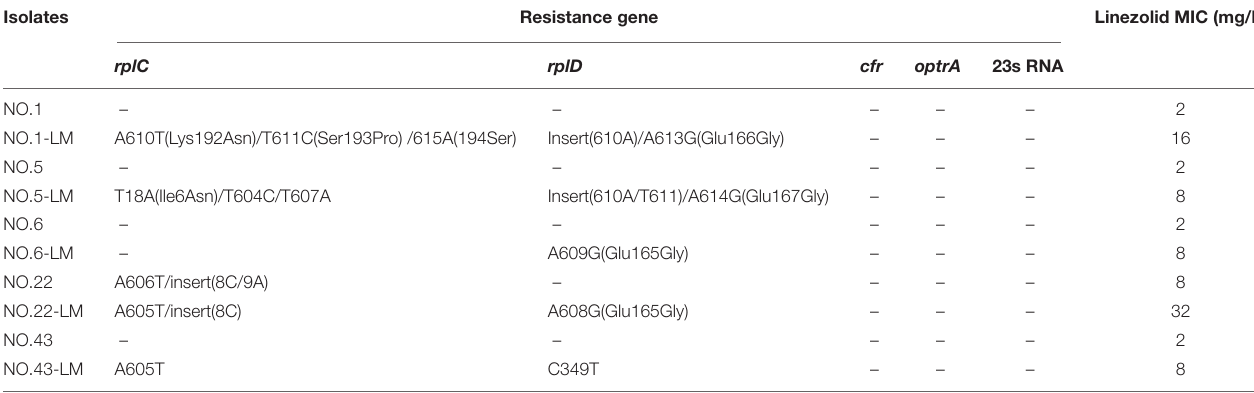
TABLE 3 | MIC values of linezolid and resistance mechanisms in linezolid resistant-mutants obtained from the MPC study of linezolid alone. Isolates